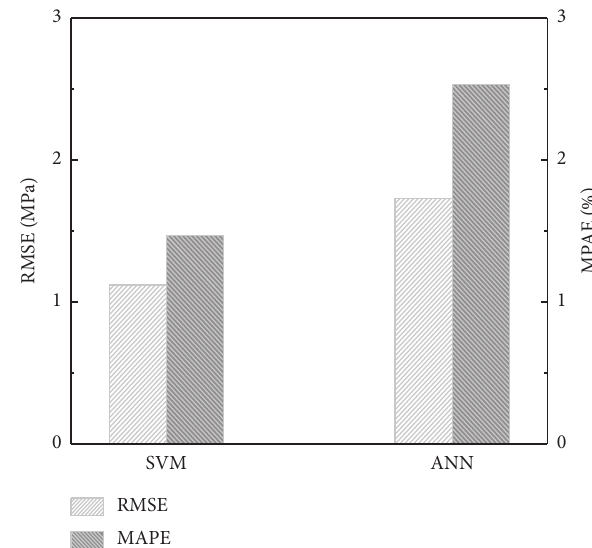
Figure 11: Comparison between SVM and ANN